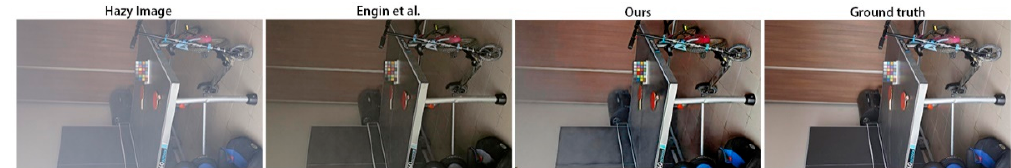
Figure 6. Dehazing results following the application of the proposed method and CycleDehaze [9] to the O-HAZE dataset [10]. Table 2. Evaluation of quantitative